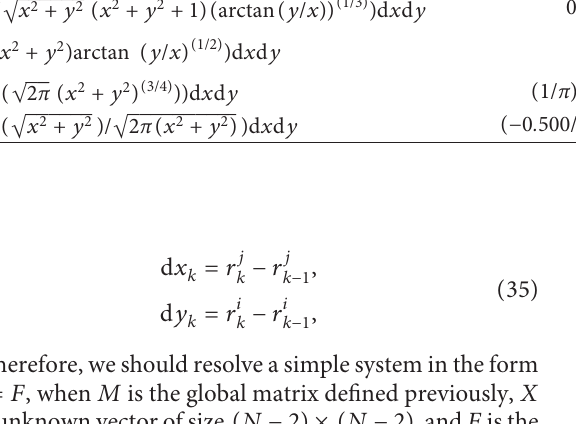
Table 1: Comparison between numerical integration using δ f ( x, y ) d x d y 􏽒 Ω